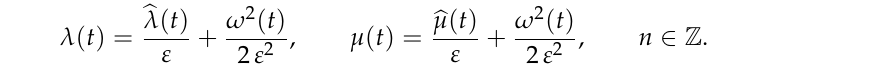
and V ∗ . The parameters 1